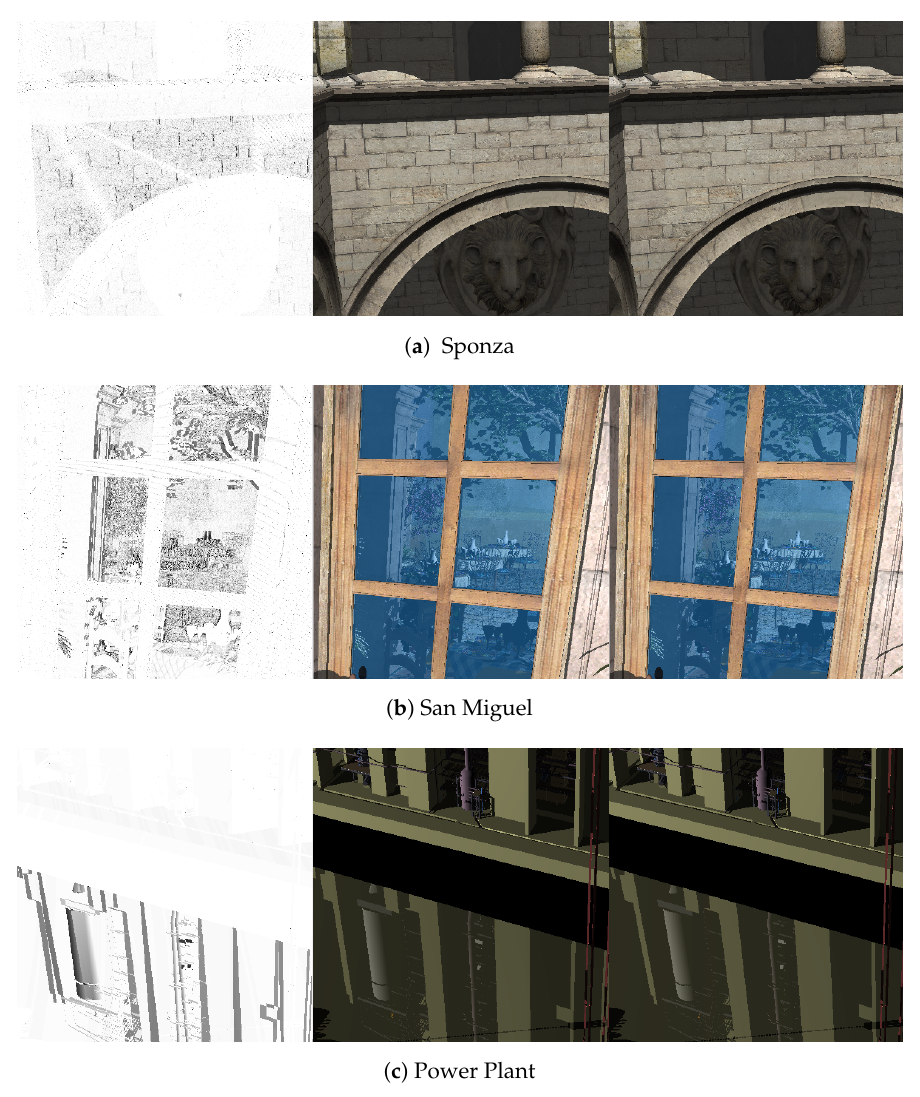
Figure 3. Comparison with ground truth images (partially enlarged). For each triplet of images, the ground truth image ( middle ) is compared with our result ( right ), obtained by ray tracing the original and quantized triangular meshes, respectively. Even in the most problematic areas, the visual difference is quite